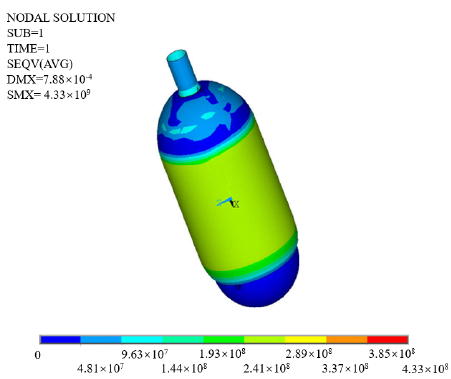
Figure 5. Stress cloud diagram.